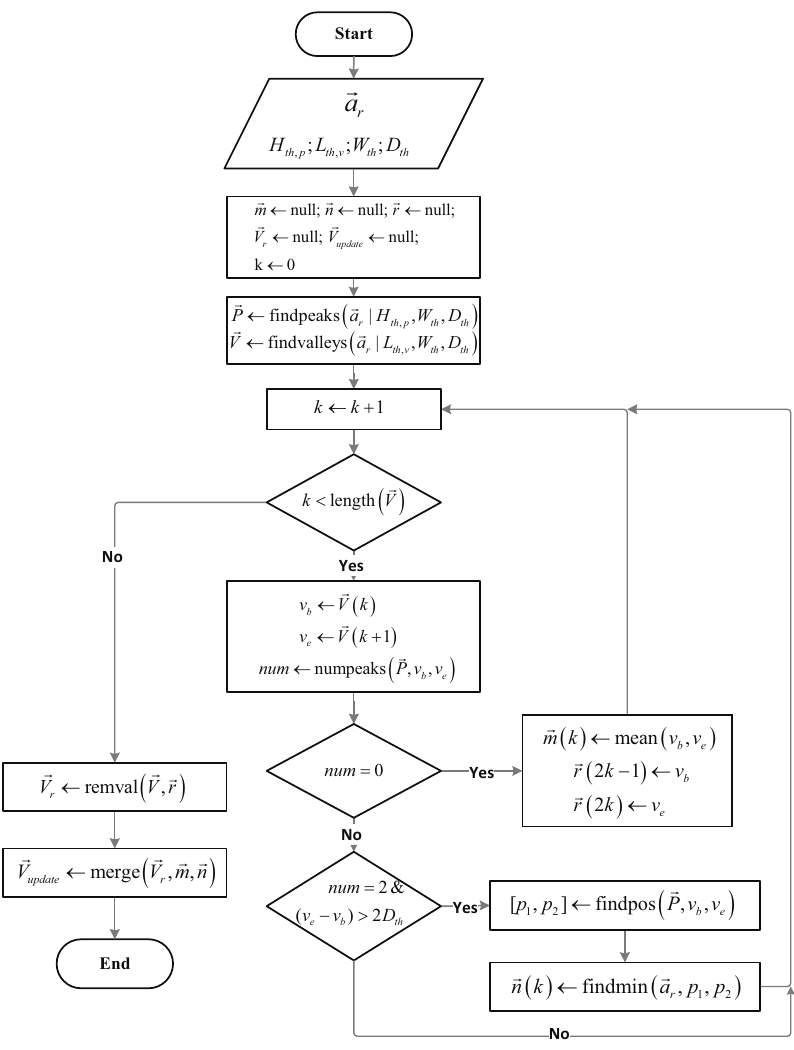
Figure 5. Flowchart of minima-adjustment